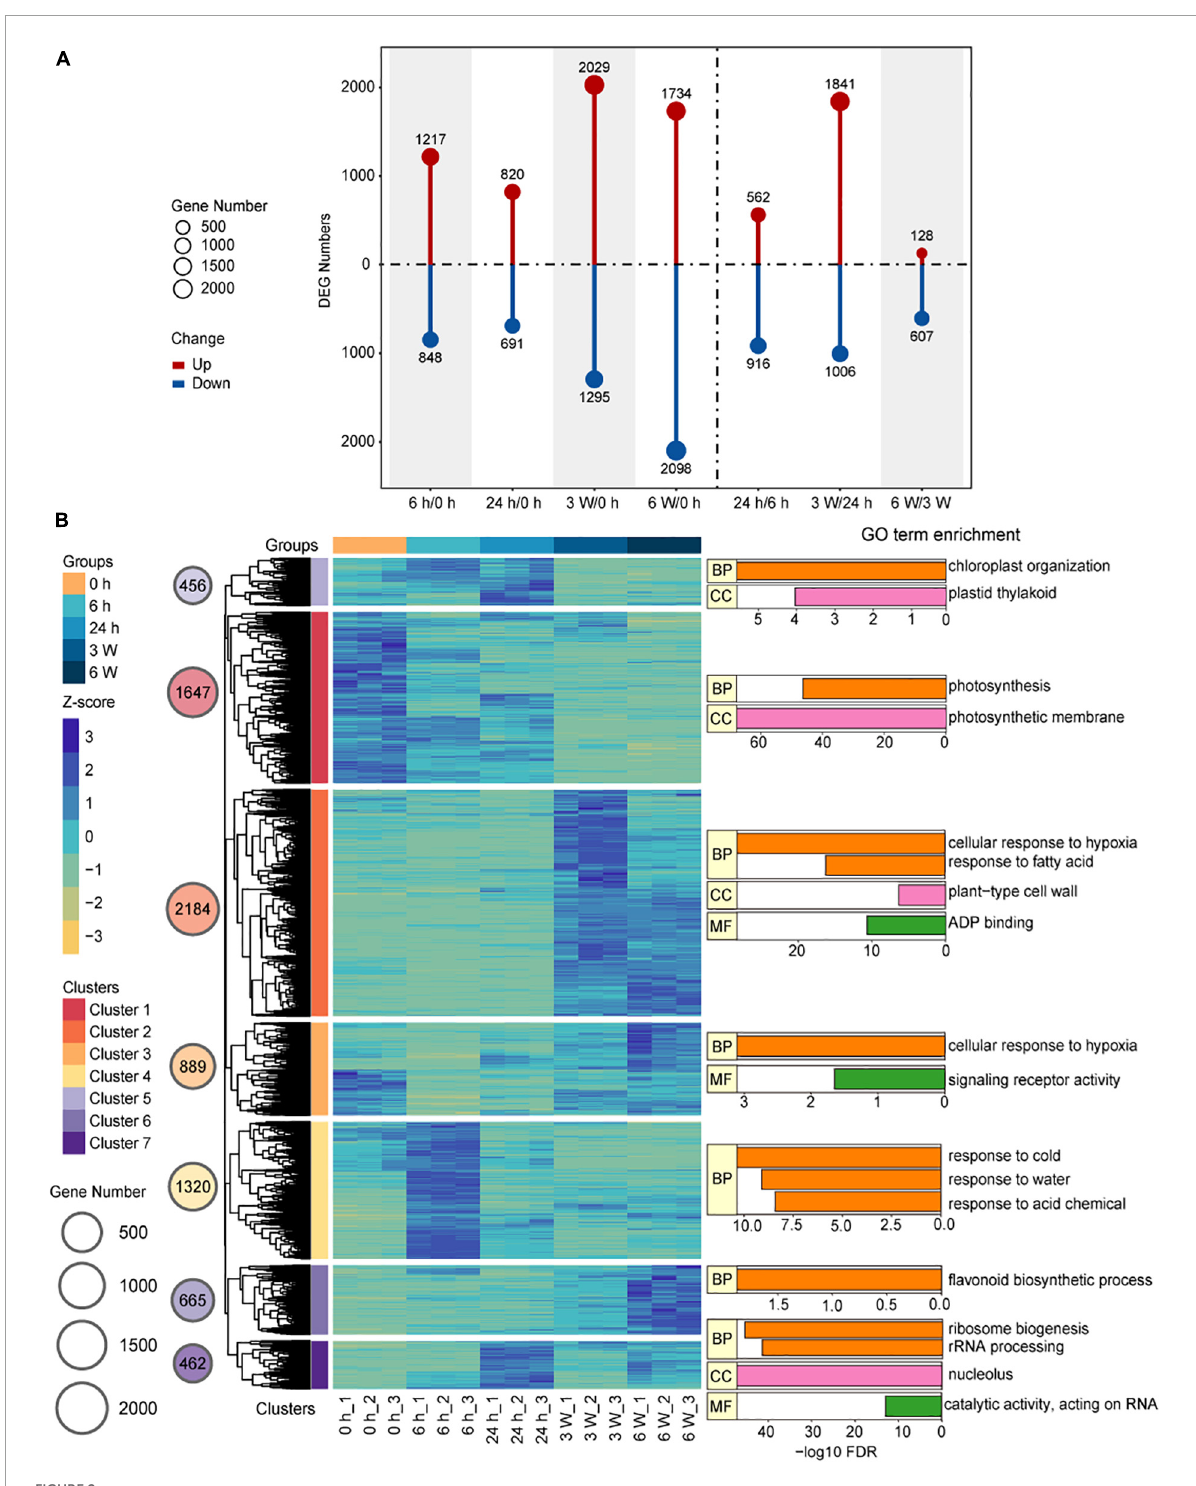
FIGURE2 Changes of the transcriptome during cold treatment in Arabidopsis . (A) Bar graph showing total numbers of differentially upregulated (red) and downregulated (blue) genes at each pairwise time point. (B) Hierarchical clustering and heat map of Arabidopsis DEGs and Key GO Terms. The groups, Z-score values, and Clusters were assigned different colors. The gene number of the different clusters was shown on circle size. Bar plot of –log10 transformed FDR values are shown. BP, biological process; MF, molecular function; CC, cellular